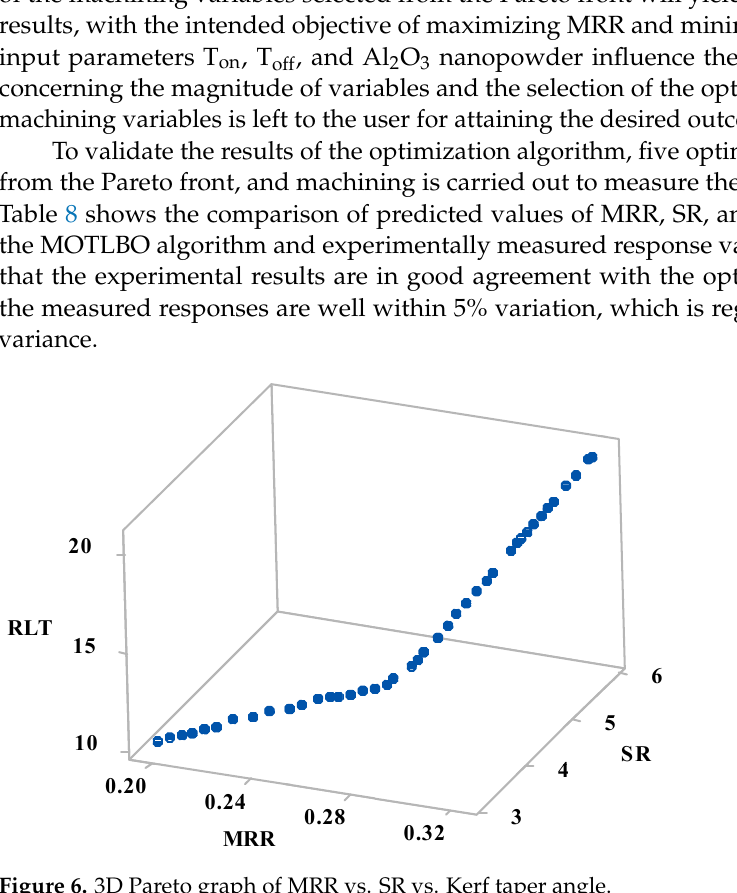
Figure 6. 3D Pareto graph of MRR vs. SR vs. Kerf taper angle. Table 8. Confirmatory trials.